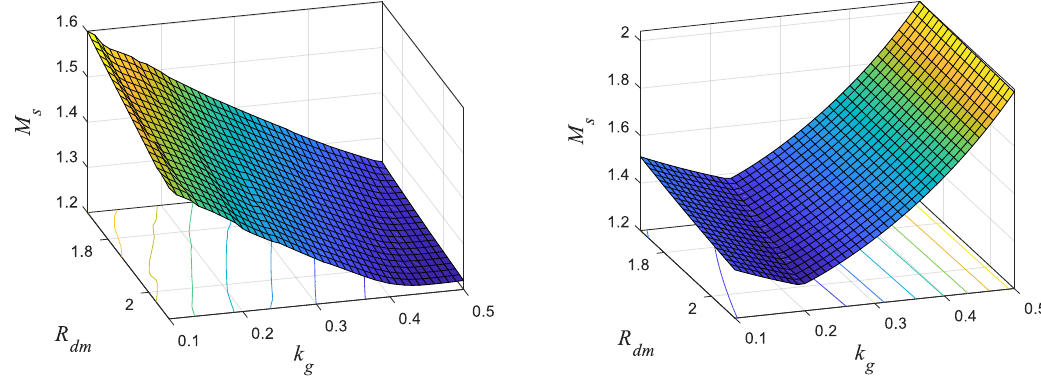
Figure 18. The distribution of M s with di ff erent k g and R dm for Example 1 ( left ) and Example 3 ( right